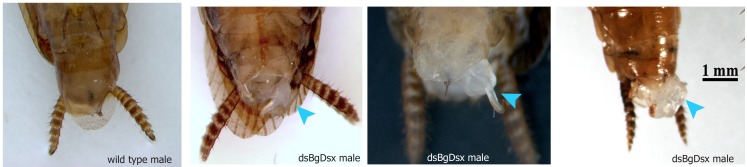
Representative sampling of tissue extrusions found in dsBgDsx males of Blattella germanica (light blue arrowheads).